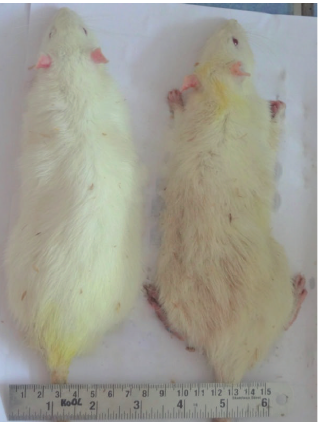
Figure 2: Time course changes of blood glucose level of NC ( 𝑛 = 8 ), HF-DC group ( 𝑛 = 7 ). Values are expressed as mean ± SD. ∗∗∗ 𝑝 < 0.001 , NC versus HF-DC.